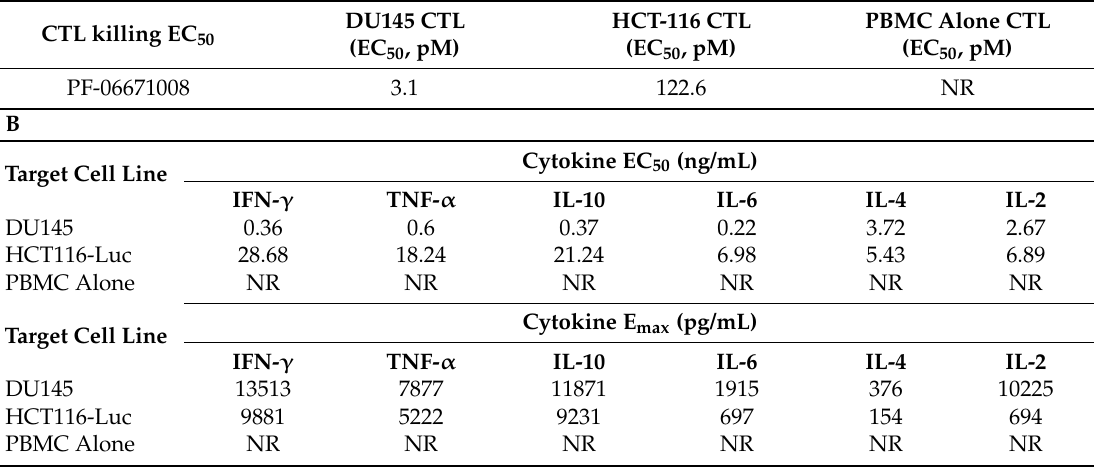
Table 6. ( A ) EC 50 values for PF-06671008-mediated redirected killing of target cells using